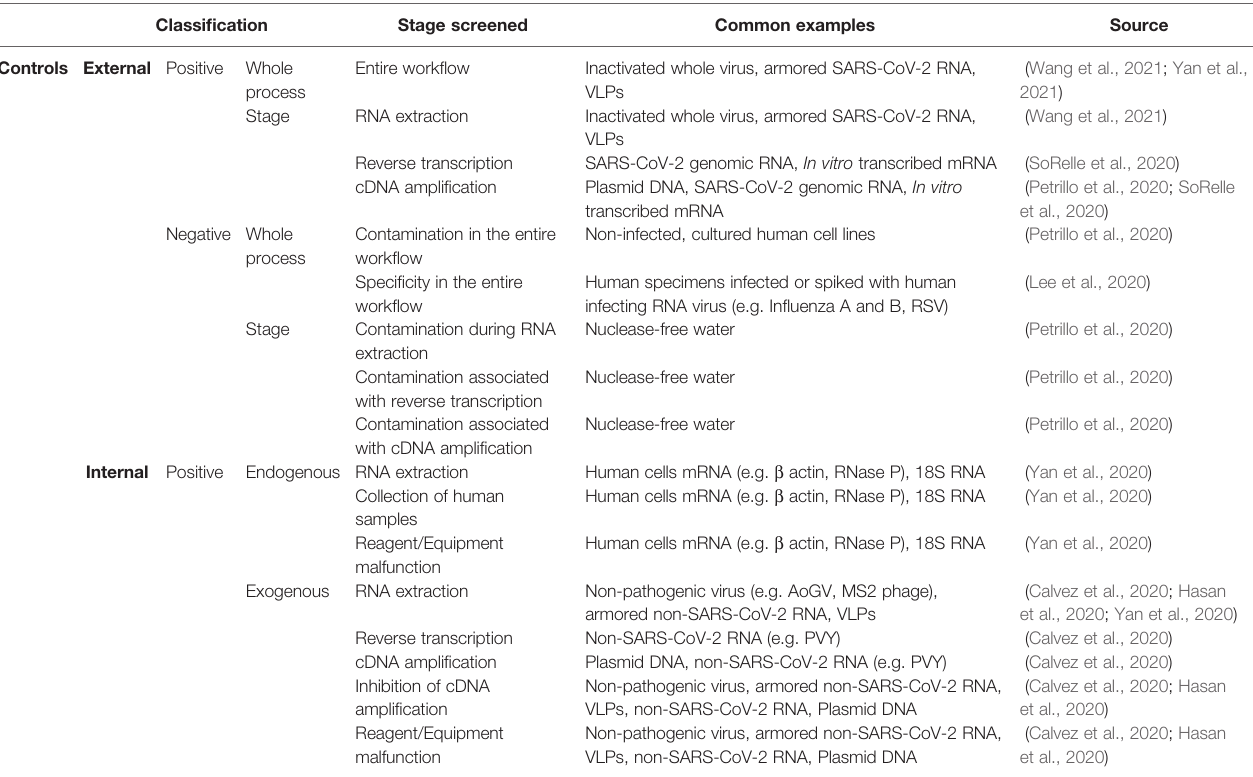
TABLE 5 | Compilation of the types of controls and corresponding examples used in the context of NAATs targeted for SARS-CoV-2